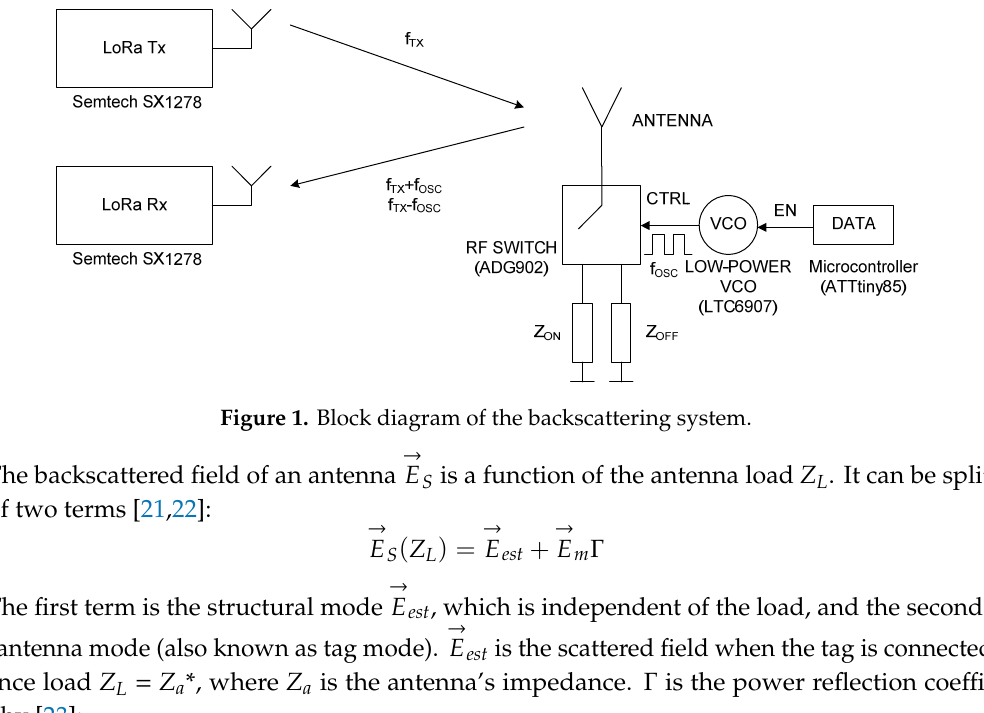
Figure 2. Photograph of LoRa bottom backscatter. Microcontroller and top layer with the RF switch and oscillator.